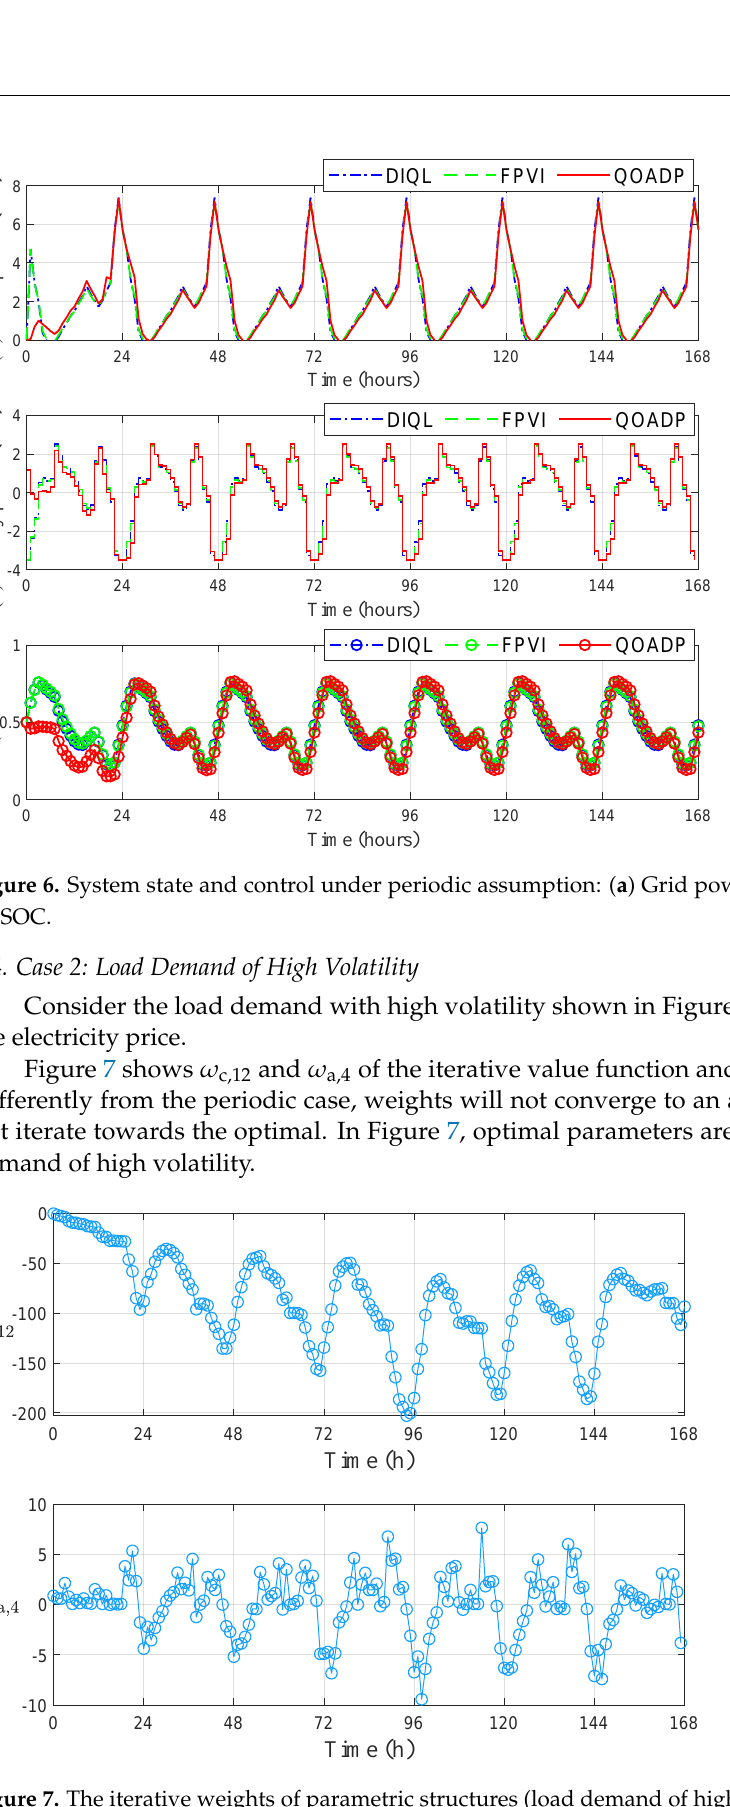
Figure 7. The iterative weights of parametric structures (load demand of high